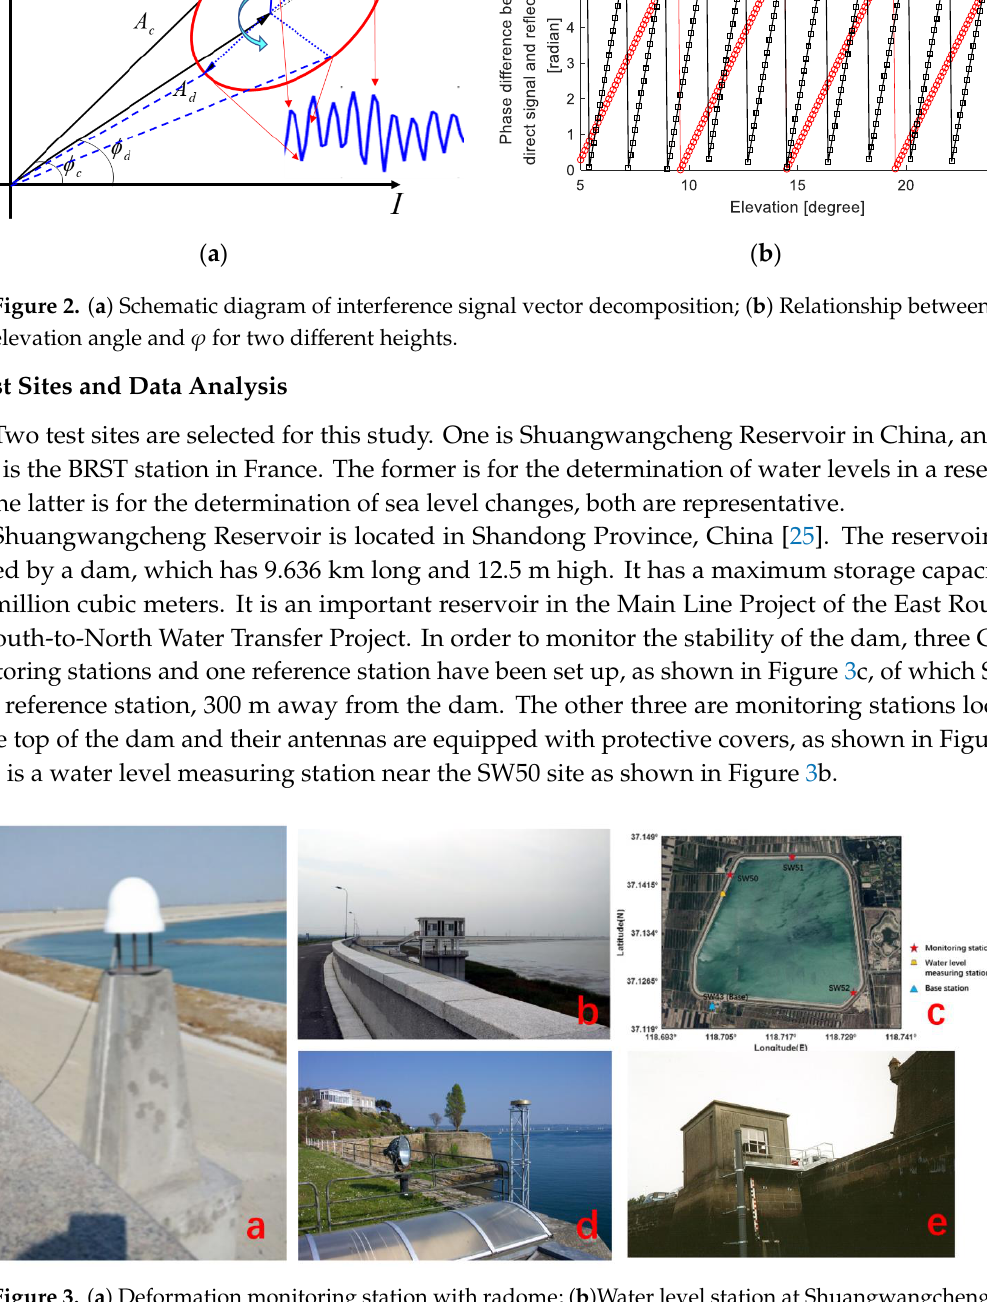
Figure 3. ( a ) Deformation monitoring station with radome; ( b )Water level station at Shuangwangcheng Reservoir; ( c ) Dam monitoring stations and an overview of the reservoir; ( d ) The BRST station at the Atlantic coast of France; ( e ) Tide station near BRST station.